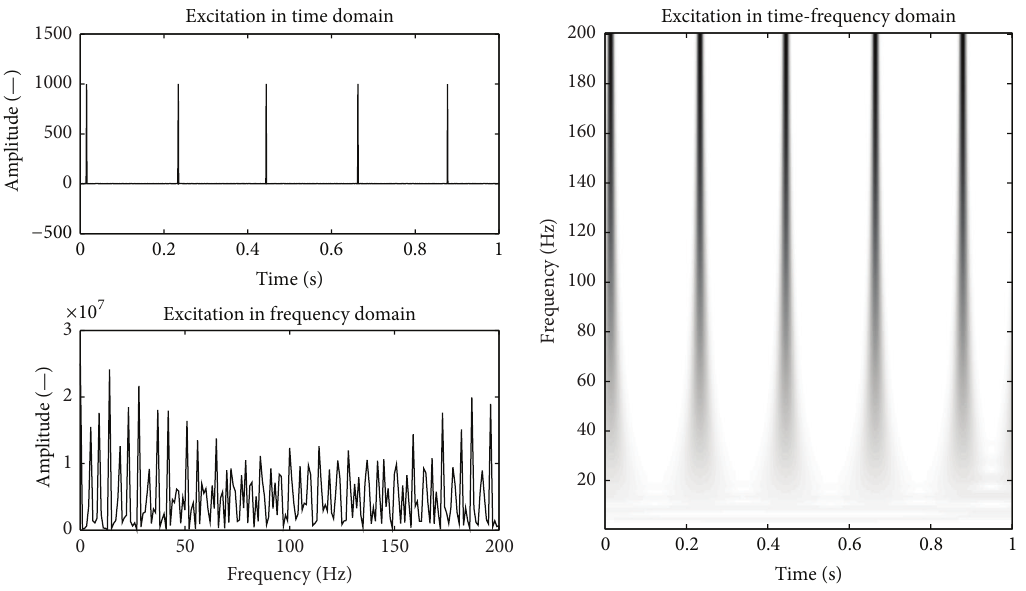
Figure 5: Random impact excitation in the time, frequency, and combined time-frequency domains.